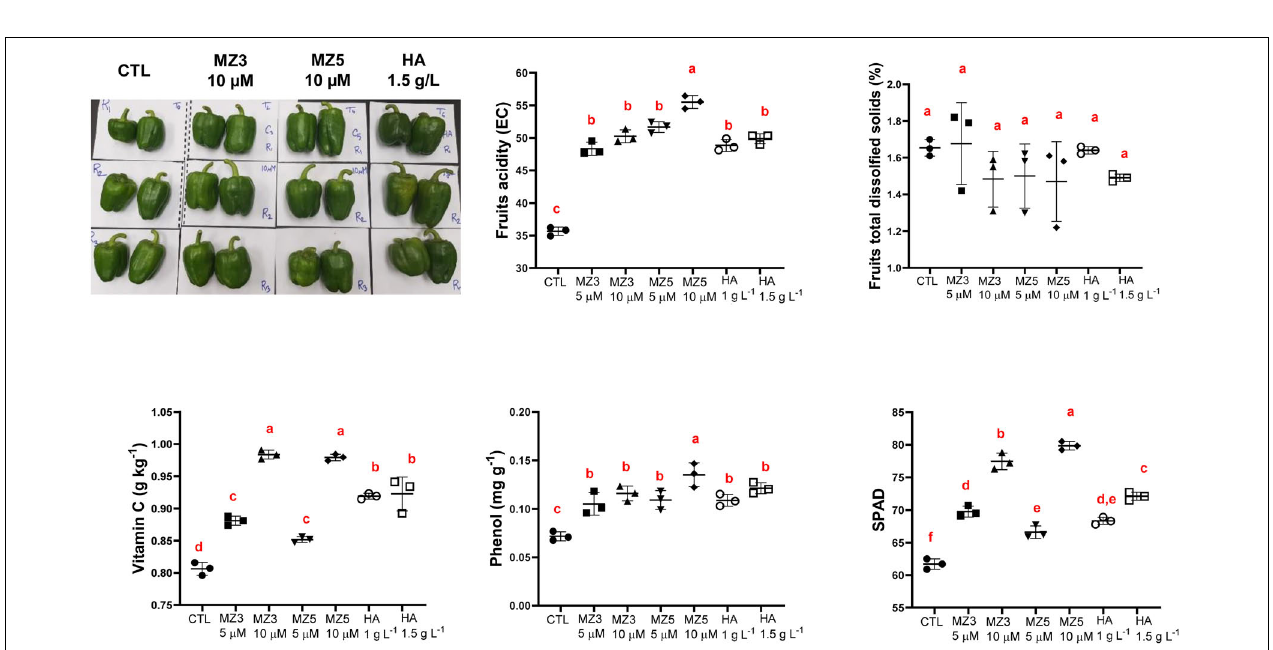
FIGURE 5 | Biochemical analysis of fruits upon MiZax treatment on green pepper from the field of the KAU, performed in 2020. Represented harvested fruits from CTL, 5 µ M MZ3, 5 µ M MZ5, and 1.5 g l − 1 HA application were shown here. Each data point represents the average from 15 plants of three plots ( n = 3). Data represent mean ± SD . Statistical analysis was performed using ANOVA and the Tukey’s post hoc test. Different letters denote significant differences ( p < 0.05). Symbols ( • , CTL; (cid:4) , 5 µ M MZ3; (cid:78) , 10 µ M MZ3; (cid:72) , 5 µ M MZ5; (cid:7) , 10 µ M MZ5;